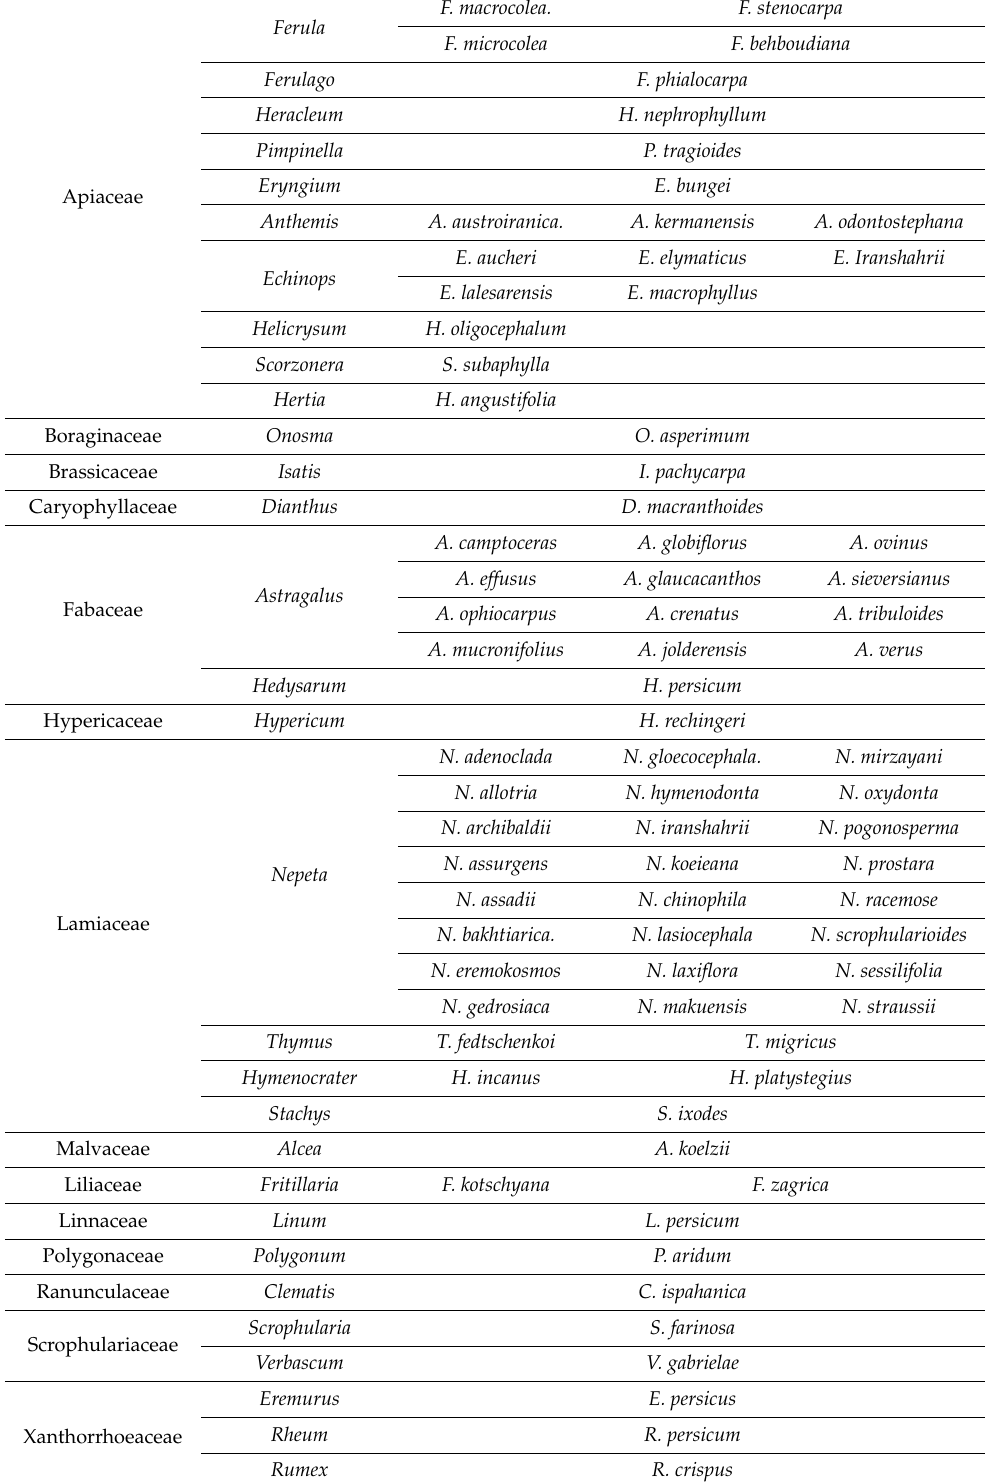
Table 2. A list of some neglected endemic MAPs of Iranian